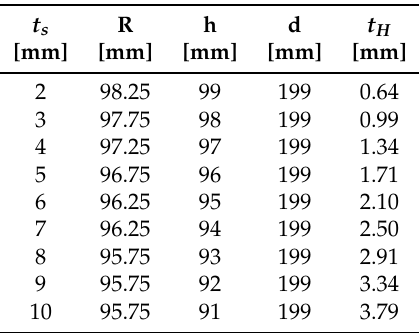
Figure 15. The thickness of a dome produced by blowing depends on the height/ratio. Table 8. Geometrical